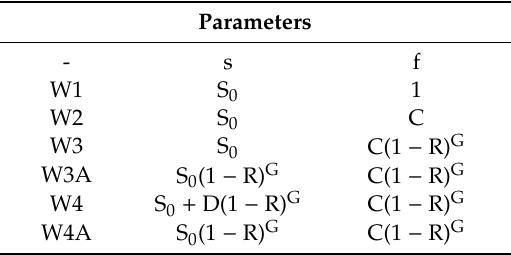
Table 1. Sendeckyj’s additional models for fatigue life predictions.